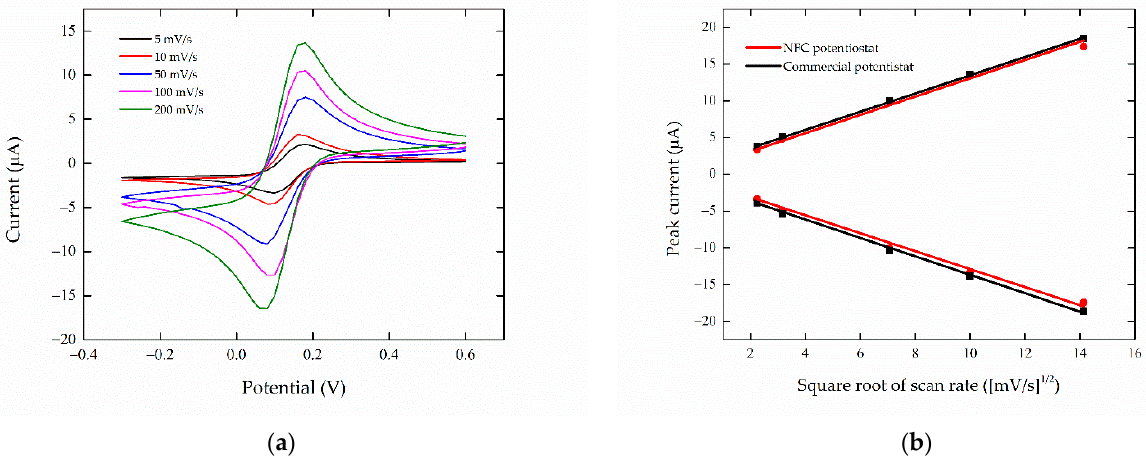
Figure 4. ( a ) Cyclic voltammograms of 1 mM potassium ferricyanide/0.1 M KCl on the NFC potentiostat sweeping the potential between − 300 and 600 mV, at various scan rates. ( b ) The linear relationship of peak current and square root of scan rate obtained from the NFC potentiostat (red) and the commercial potentiostat (black).